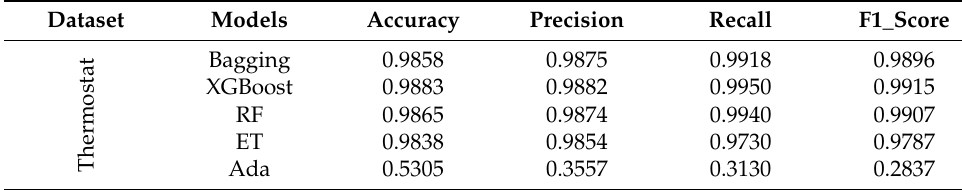
Table 5. The classification report for the IIoT Thermostat dataset.